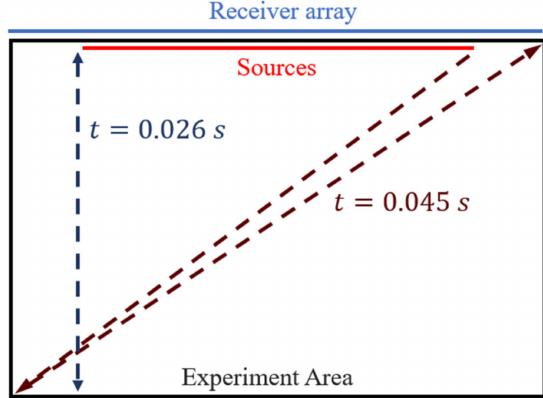
Figure 8. Illustration of travel